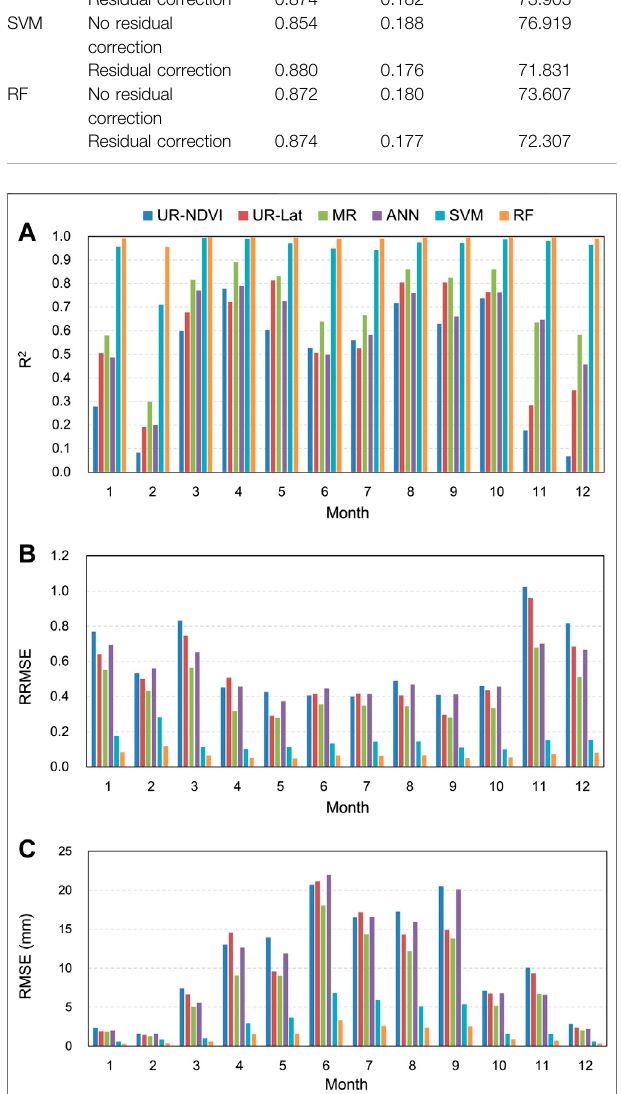
FIGURE 10 | Evaluation results of different downscaling methods using the original GPM IMERG V06B data at each month from 2001 to 2015 (A-C) R2, RRMSE, and RMSE.